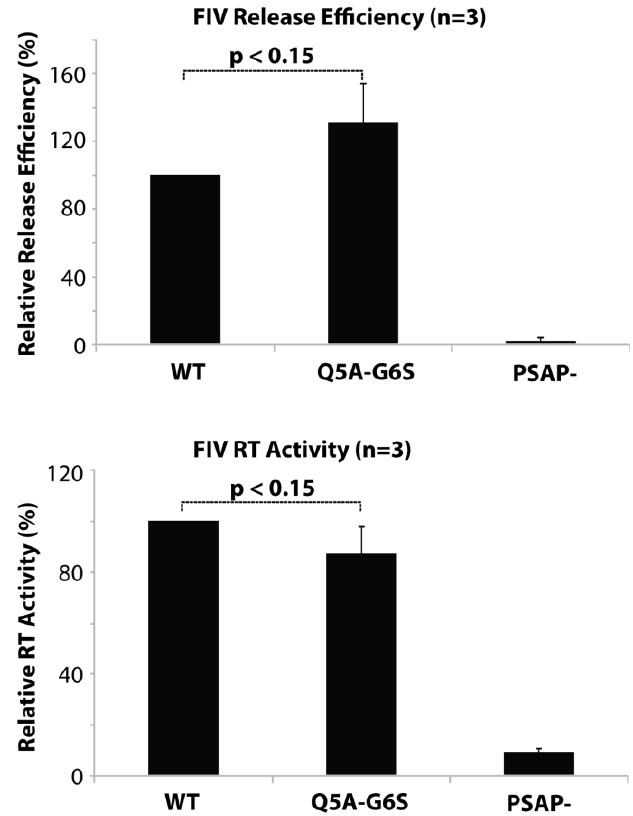
Figure 1. Mutation of the feline immunodeficiency virus (FIV) Gag myristylation signal does not significantly affect virus assembly or release from transfected 293T cells.